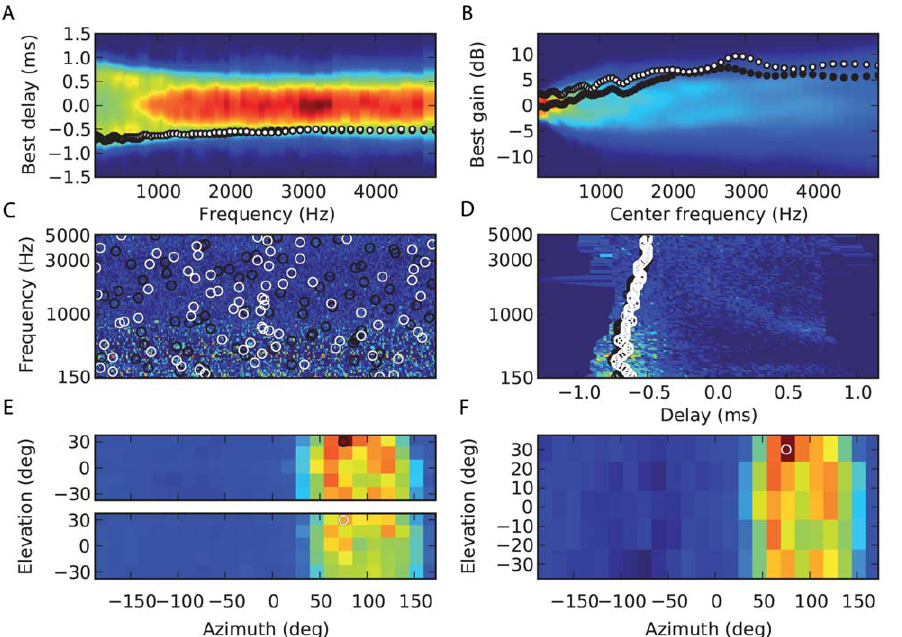
Figure 11. Simultaneous representation of two acoustical environments (two sets of HRTFs). (A, B) Best delay and relative interaural gain for two assemblies (black and white circles) corresponding to the same location in the two different HRTF sets, as in Figure 8E and F. (C, D) Response of the postsynaptic neurons to a sound at a particular location with one HRTF set, as in Figure 3C and D. The black circles show the neurons tuned to the correct location for one set, the white for the other. (E) Summed responses of location-specific assemblies for the two HRTF sets (each assembly has a preferred location and set), for a particular location and HRTF set. The circles represent the source location in the correct (black) and incorrect (white) set. The maximally activated assembly encodes for both location and HRTF set. (F) Summed responses of neural assemblies as a function of preferred location, for both sets (sum of the two sets of responses in E).